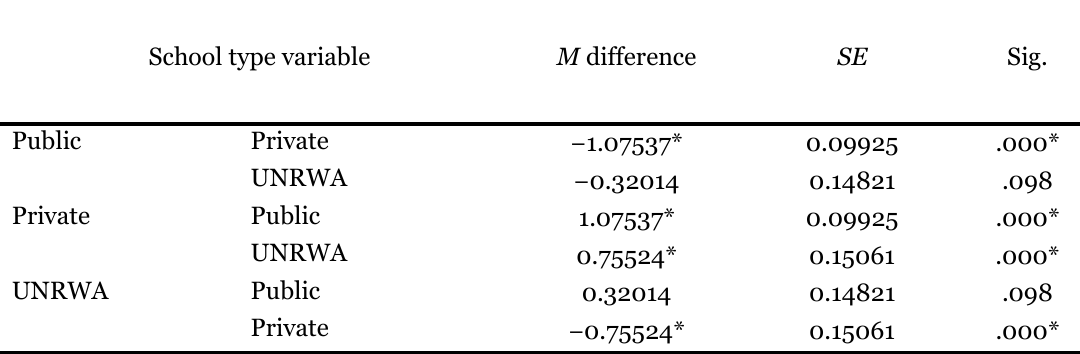
Schiff’s Post Hoc Test Results of Parents’ Perceptions Toward the Distance Learning Process According to School Type